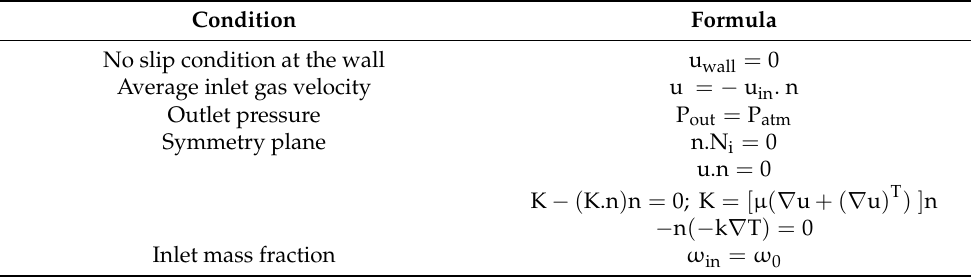
Table A2. Summary of CFD model boundary conditions [21]. Adapted with permission from S. Chiuta, R.C. Everson, H.W.J.P. Neomagus, L.A. Le Grange, D.G. Bessarabov, International Journal of Hydrogen Energy; published by Elsevier, 2014.